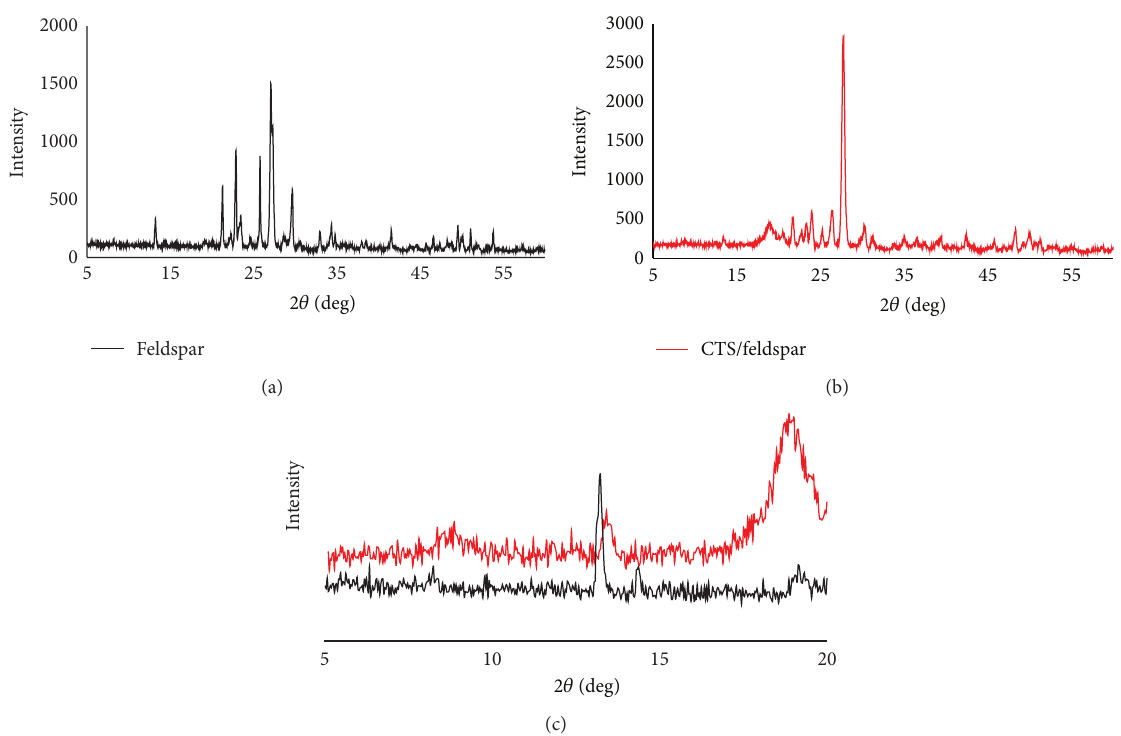
Figure 2: XRD patterns of (a) feldspar and (b) CTS/feldspar biobased